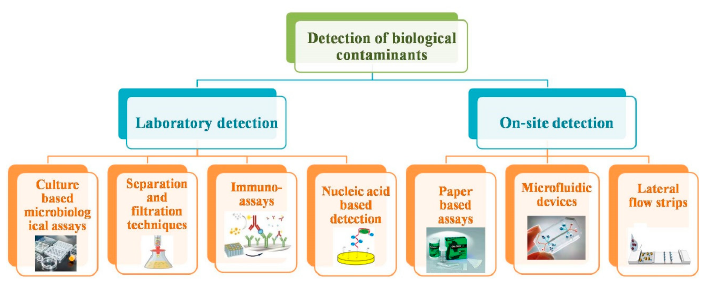
Figure 1. Detection methods for biological contaminants.